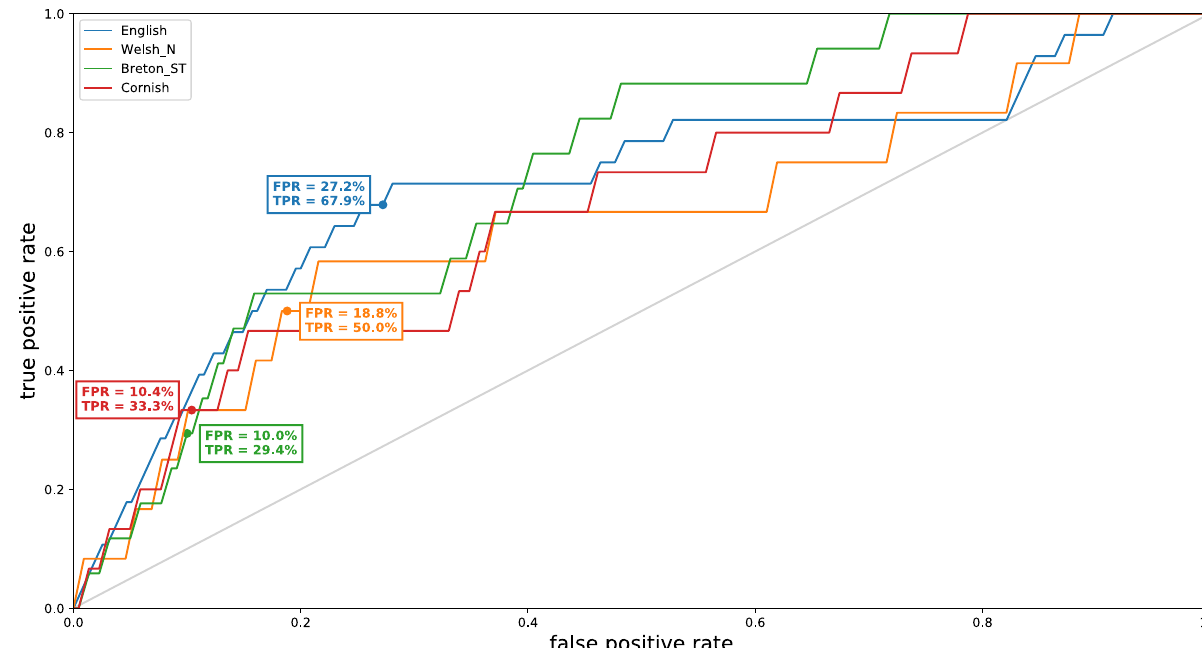
Fig. 6 The receiver operating characteristic (ROC) curve comparing known and predicted loanwords. The curve shows all possible trade-offs between the true positive rate (TPR) and the false positive rate (FPR) under varying posterior probability thresholds. The labelled points are the FPR and TPR for a posterior probability threshold of